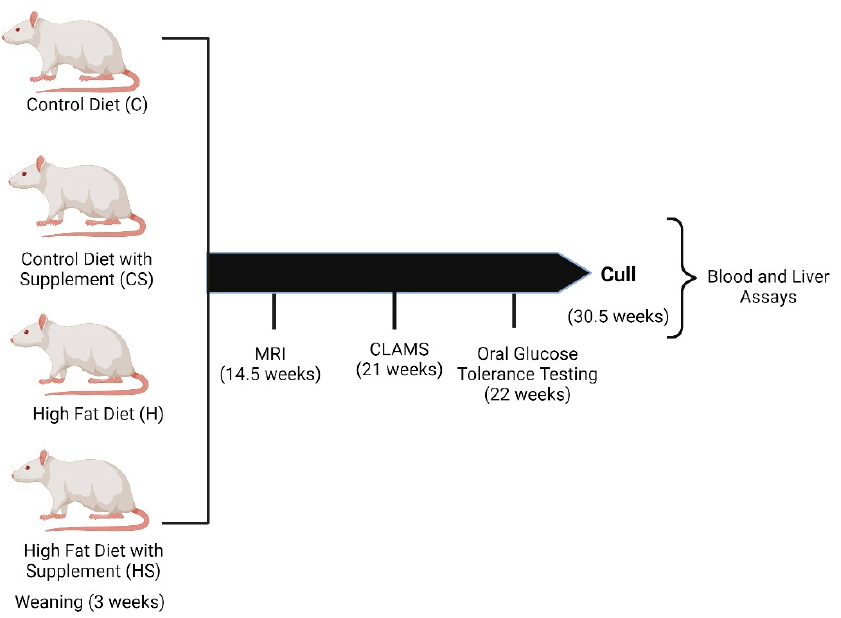
Figure 1. Experimental design and timeline.